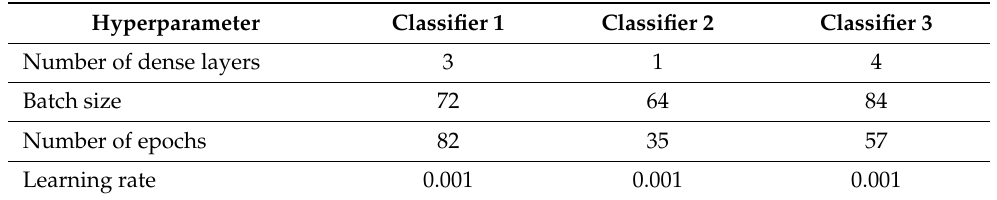
Table 3. Hyperparameters used in the